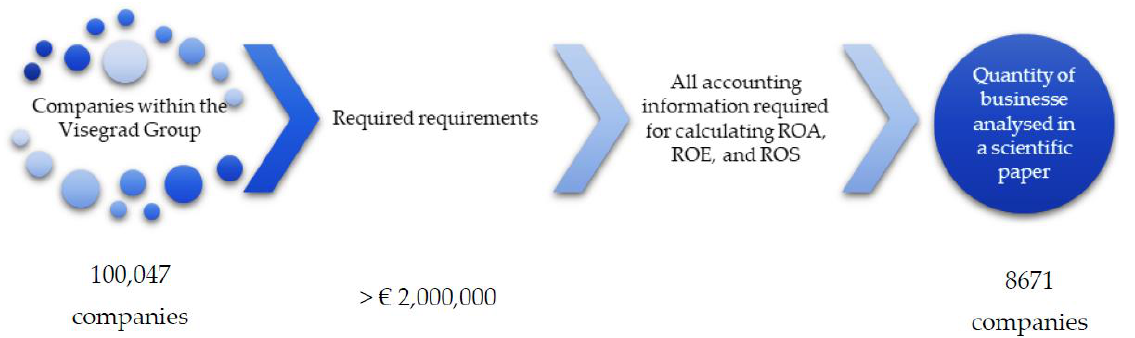
Figure 2. Original and final sample of enterprises. Source: own research.